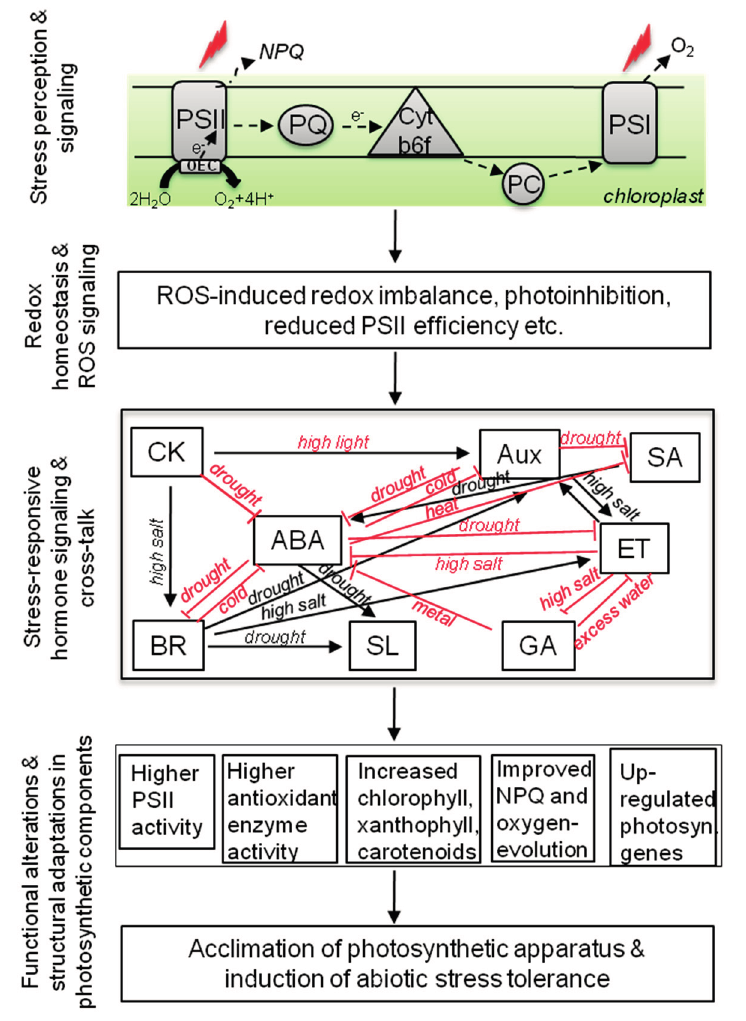
Figure 1. Involvement of stress-responsive phytohormones and their crosstalk in the protection of photosynthetic machinery under abiotic stress conditions. Abiotic stress factors (indicated as red lightning symbols) mainly target the photosynthetic reaction centers, photosystem II (PSII), and photosystem I (PSI). PSII is the most susceptible reaction center as it is involved in the water-splitting process of photosynthesis where water is converted to oxygen and protons through the oxygen-evolving complex (OEC) and the electrons (e − ) are released and transferred to the PSI complex via plastoquinone (PQ), cytochrome b6f complex (Cytb6f), plastocyanin (PC), and several other intermediatory molecules. Under stressful conditions, plants dissipate the excess energy in the form of heat through the light-harvesting antenna molecules and this mechanism is known as non-photochemical quenching (NPQ). Abiotic stress-induced photoinhibition creates a redox imbalance and reactive oxygen species (ROS) molecules are generated that are highly detrimental for the plant cells. In addition, ROS molecules inhibit the PSII damage-repair process. With the onset of abiotic stress